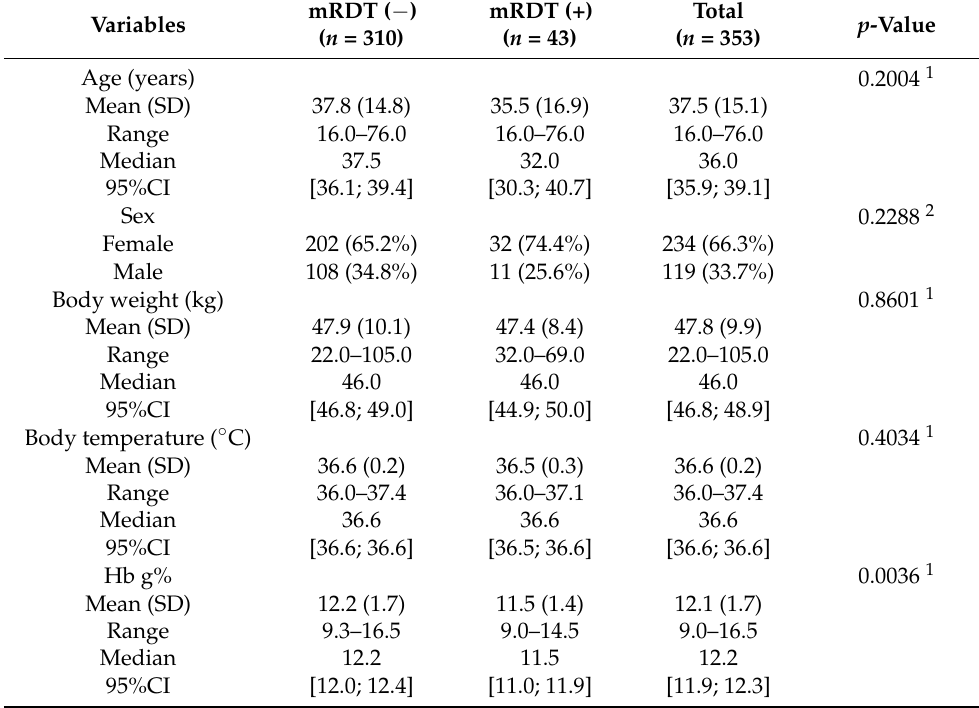
Table 2. Characteristics of asymptomatic adults ( n =